Question: Provide a publication-style caption for this figure.
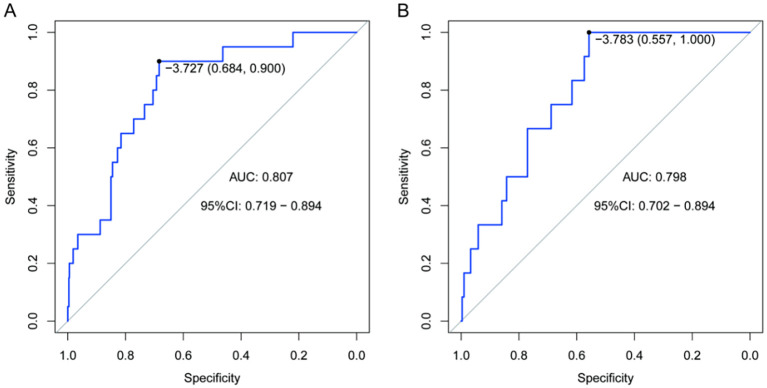
Answer: ROC curve. (A) Train; (B) Test.